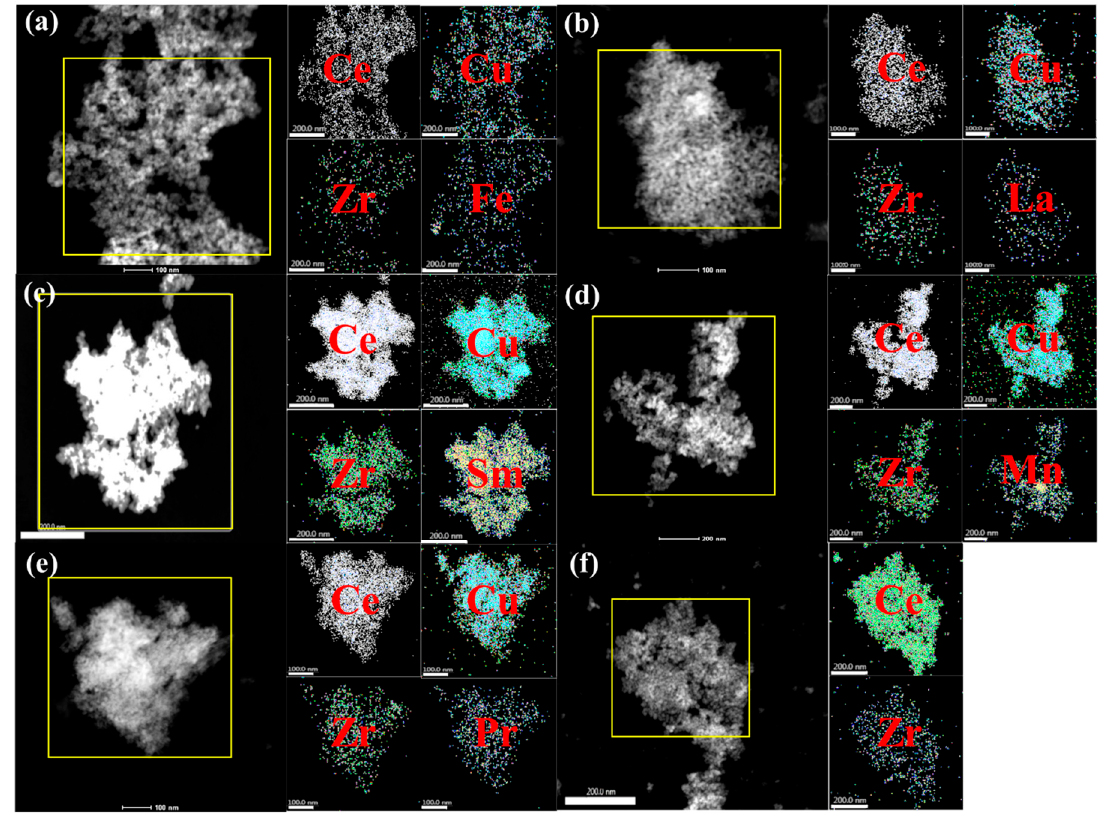
Figure 4. STEM and EDS element mapping images showing the spatial distribution of Ce, Zr, Cu and M (M = Fe, La, Sm, Mn, Pr) elements: ( a ) 15CuO-3Fe 2 O 3 / M-Ce80Zr20, ( b ) 15CuO-3La 2 O 3 / M-Ce80Zr20, ( c ) 15CuO-3Sm 2 O 3 / M-Ce80Zr20, ( d ) 15CuO-3MnO 2 / M-Ce80Zr20, ( e ) 15CuO-3PrO 2 / M-Ce80Zr20, ( f ) M-Ce80Zr20.